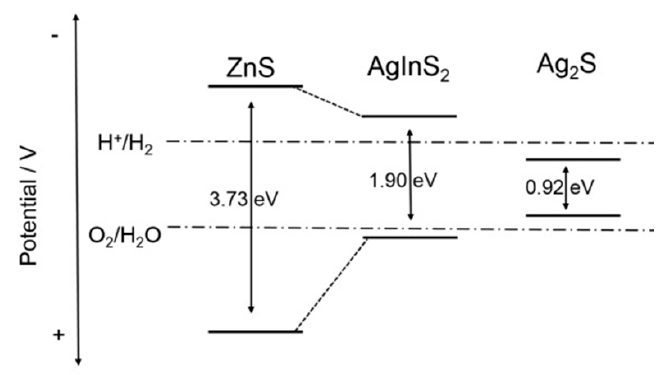
Figure 6. A diagrammatic scheme of energetic band structure of AgInS 2 -Ag 2 S-ZnS (Ag:Zn = 1:1).